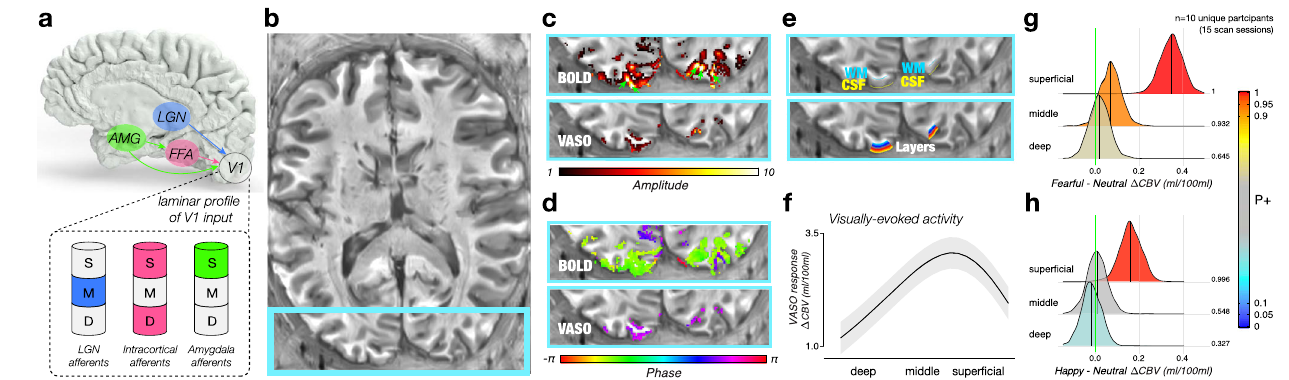
Fig. 3 | Facial valence modulation speci fi c to super fi cial layers of V1. a Three input pathways to V1 have distinct laminar pro fi les: LGN afferents terminate in the middle layer (M) 111,112 , cortico-cortical afferents, such as from FFA, terminate in super fi cial and deep layers (S and D) 15 , and amygdala afferents terminate exclusively in the super fi cial layer (S) 15,16 . AMG, amygdala; FFA, fusiform face area; LGN, lateral geniculate nucleus. b Axial slice of a T1-weighted anatomical image generated from VASO timeseries 23 . Light blue line corresponds to the fi eld of view shown in c – e . c ResponseamplitudetofacestimulimeasuredwithBOLD(top)andVASO(bottom). GreenarrowsintheBOLDimageindicatehigh-amplituderesponsesinveins. d Phase (timing) of the best- fi tting sinusoid. BOLD and VASO are known to have opposite signed responses 23 , as indicated by the 180deg shift in response phase. e Central V1 ROI was de fi ned in each participant based on retinotopic analysis 34 and constrained bythewhitematter(WM;cyan)andCSF(yellow)boundaries(top).BetweentheWM